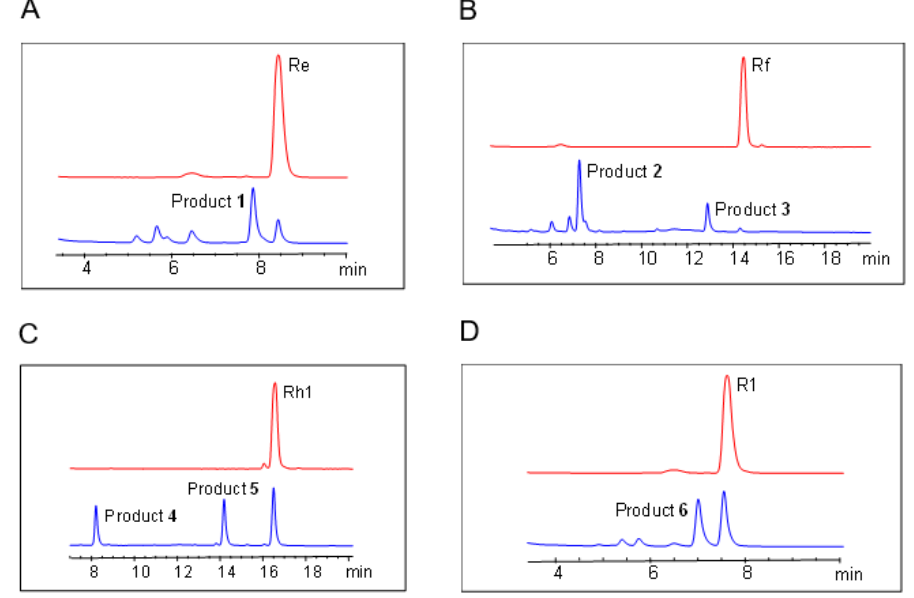
Figure 2. HPLC analysis of the glycosylated products catalyzed by UGT109A1. ( A ) Ginsenoside Re as a substrate; ( B ) Ginsenoside Rf as a substrate; ( C ) Ginsenoside Rh1 as a substrate; ( D ) Ginsenoside R1 as a substrate.